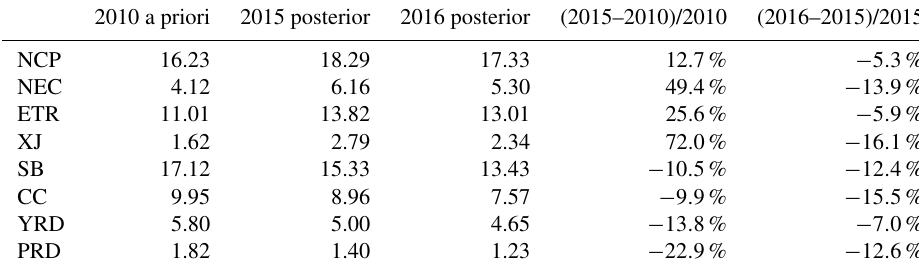
Table 3. A priori and analyzed January emissions and the changing ratios for 8 regions (units: 10 6 kgd − 1